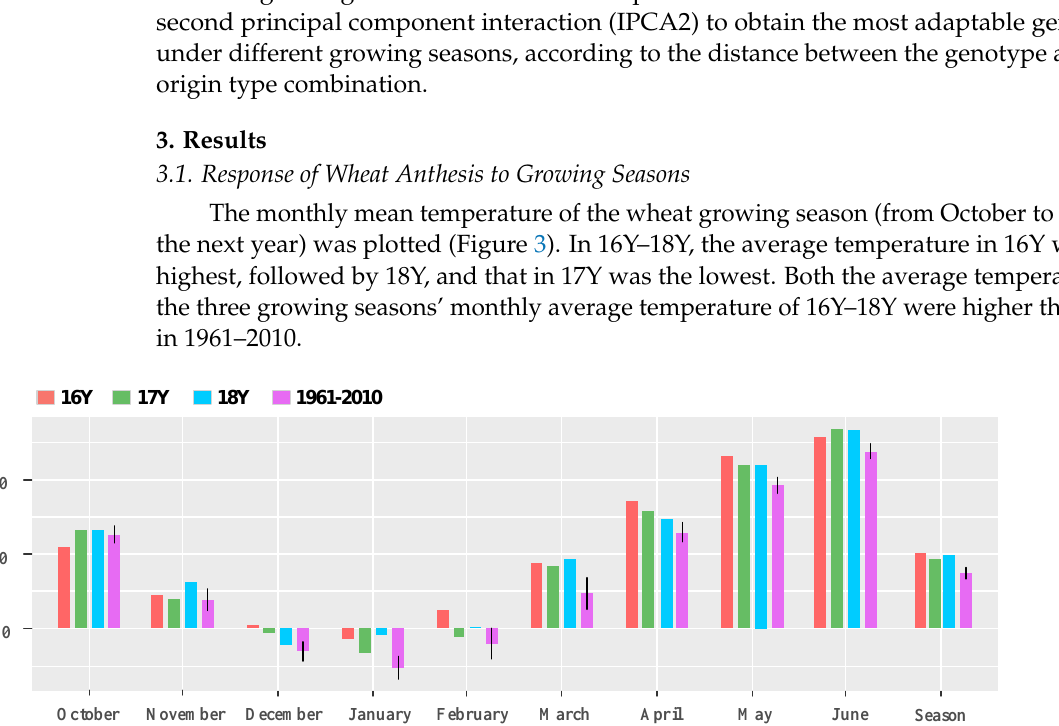
Figure 3. Bar chart of the monthly average temperature of wheat in 16Y – 18Y and the last 50 years (1961 – 2010). 16Y is from monthly average temperature from October 1961 to June 2010. Growing season is the average temperature from October to June of wheat in the whole phenophase.